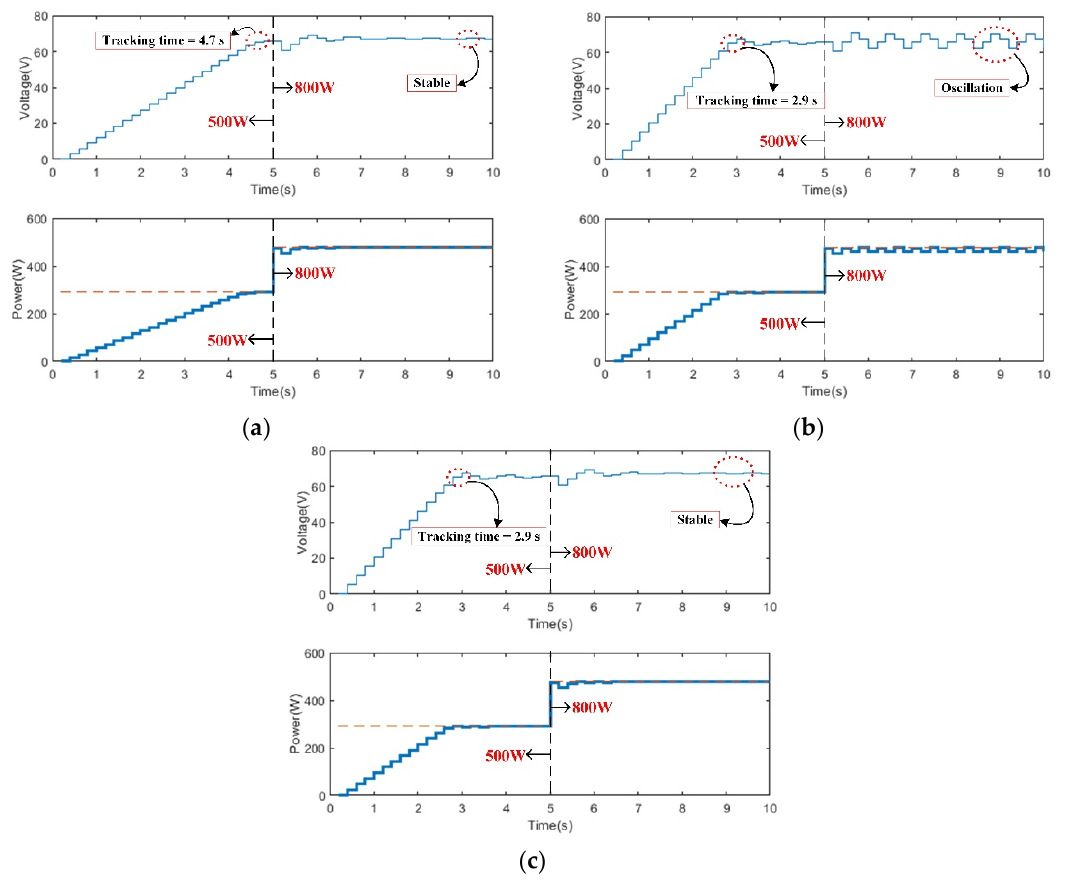
Figure 4. Simulation results of different M values ( a ) M = 0.65, ( b ) M = 1.08, ( c ) M = 1.08/0.65 under increasing irradiance level.